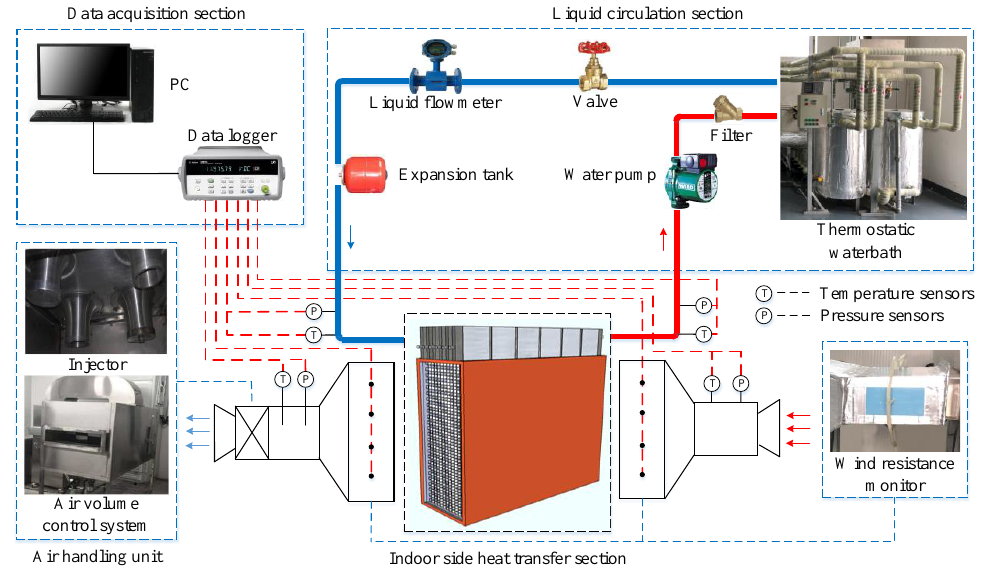
Figure 3. Schematic diagram of experimental system.